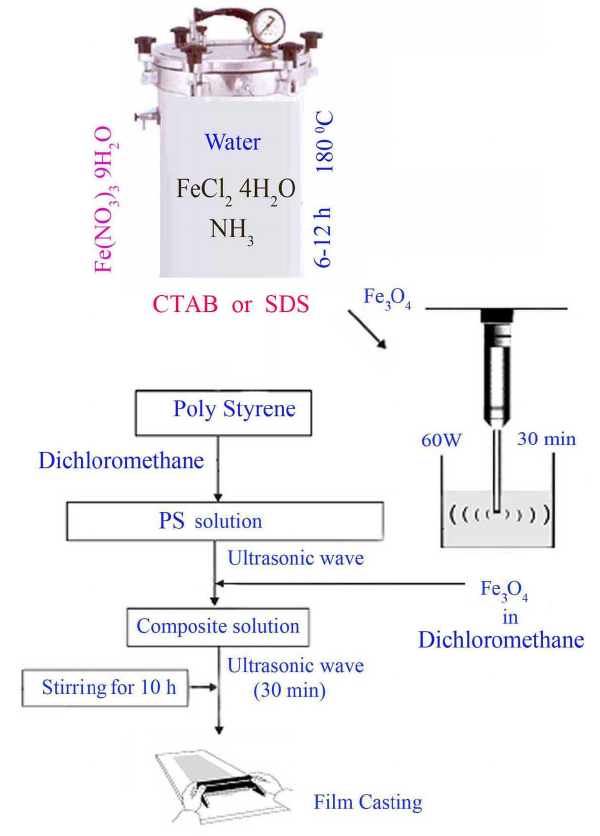
Fig. 1. Schematic of preparation of